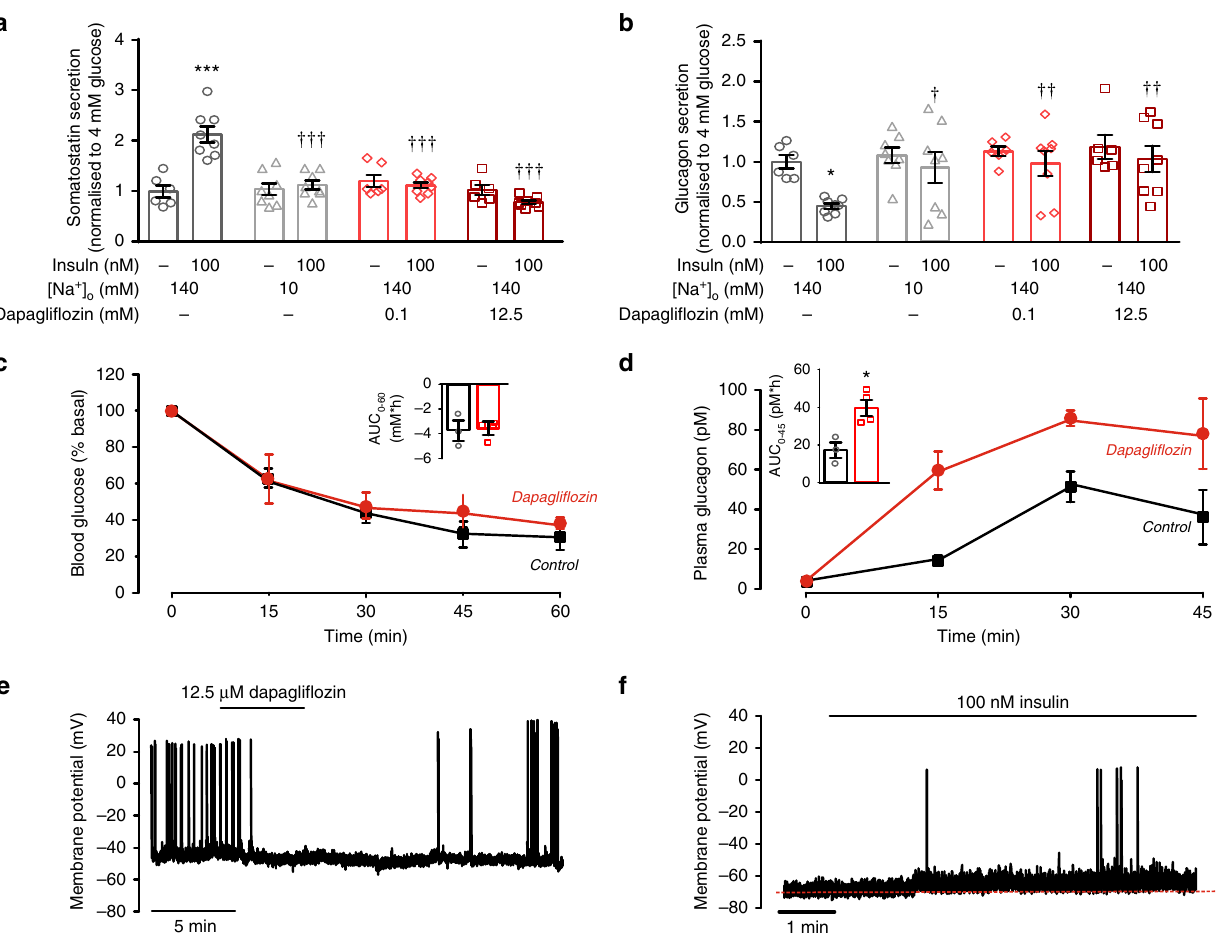
Fig. 5 Insulin activates SGLT2 in δ cells. a , b Somatostatin ( a ) and glucagon secretion ( b ) at 4 mM glucose in the absence or presence of insulin at normal or lowered (10 mM) extracellular Na + ([Na + ] o ) with or without dapagli fl ozin as indicated. Responses have been normalised to secretion at 4 mM glucose. * p < 0.05, *** p < 0.001 vs 4 mM glucose alone; † p < 0.05, †† p < 0.05 ††† p < 0.001 for comparisons with 4 mM glucose under control conditions (black